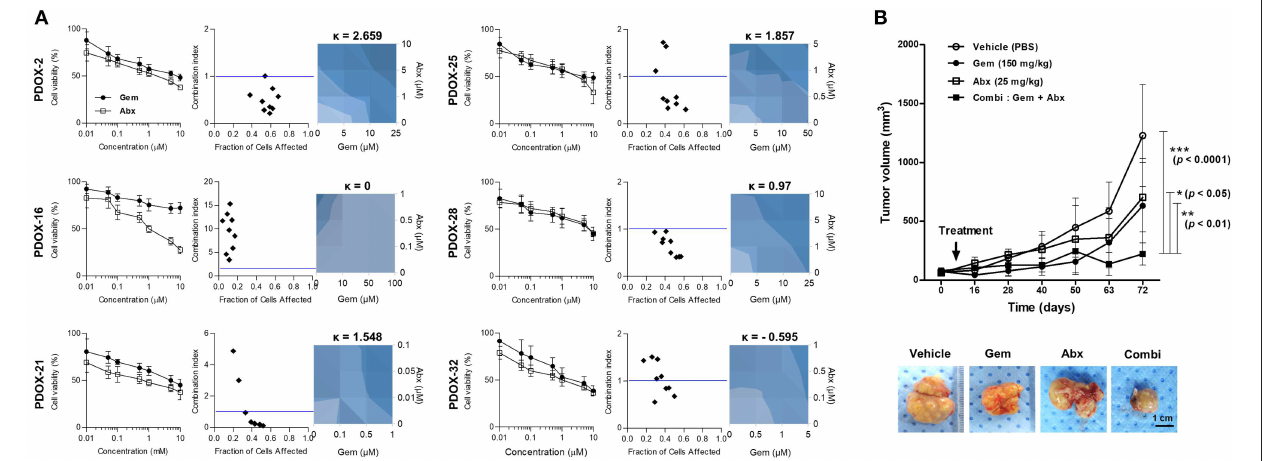
FIGURE 5 | Response of PDOX and PDOX-derived organoids to gemcitabine and Abraxane. (A) Response curves of patient-derived organoids to gemcitabine (left) and the combination of gemcitabine and Abraxane. The synergic effect of the combination of these two agents was assessed by comparing the effects of the combination of the two drugs with each alone using the CompuSyn program, with results reported as the combination index (CI) as a function of the fraction affected (Fa). Drug synergy was also calculated using BRAID models, with k > 0 indicating synergy, k = 0 indicating an additive effect, and k < 0 indicating drug antagonism (right-blue). Error bars indicate standard deviations (SD) and all experiments were performed in triplicate. (B) In vivo drug efficacy testing of combination therapy using PDOX models. Combination effects of gemcitabine and Abraxane were tested in PDOX-2 models. Average tumor volumes of treated groups are plotted in graph and representative tumors after treatment are shown (bottom). Vehicle; PBS, Gem; gemcitabine, Abx, Abraxane; Combi, gemcitabine plus Abraxane. *** p < 0.0001, ** p < 0.01, * p < 0.05. Scale bar = 1cm.